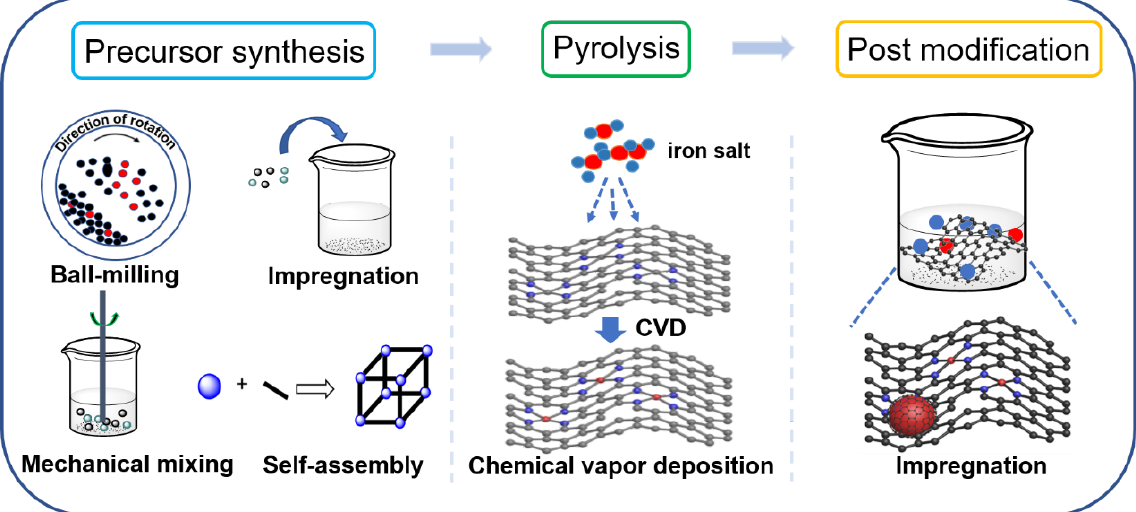
Figure 1. Schematic illustration for the introduction of iron species into carbon supports.